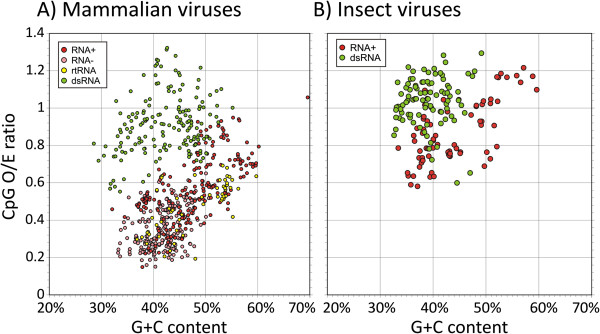
CpG dinucleotide frequencies among different classes of RNA and small DNA viruses infecting mammals and insects. Viruses were divided into groups based on the genomic composition: RNA+: positive strand RNA viruses; RNA-: negative strand RNA viruses; rtRNA: reverse transcribing viruses (Retroviridae, Hepadnaviridae and Caulimnoviridae); dsRNA: double-stranded RNA viruses; ssDNA: single stranded DNA viruses as indicated in the inset box.